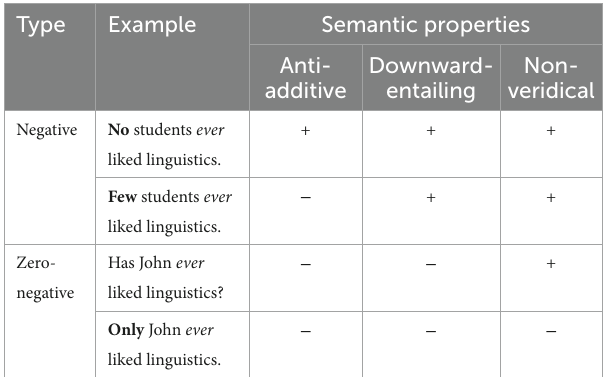
TABLE 1 Semantic properties of NPI licensing